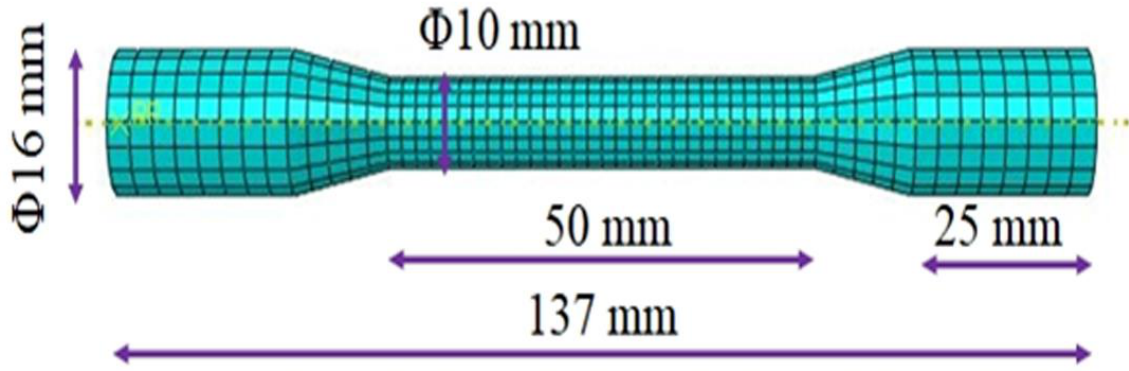
Figure 2. Round bar sample in the uniaxial creep simulation.